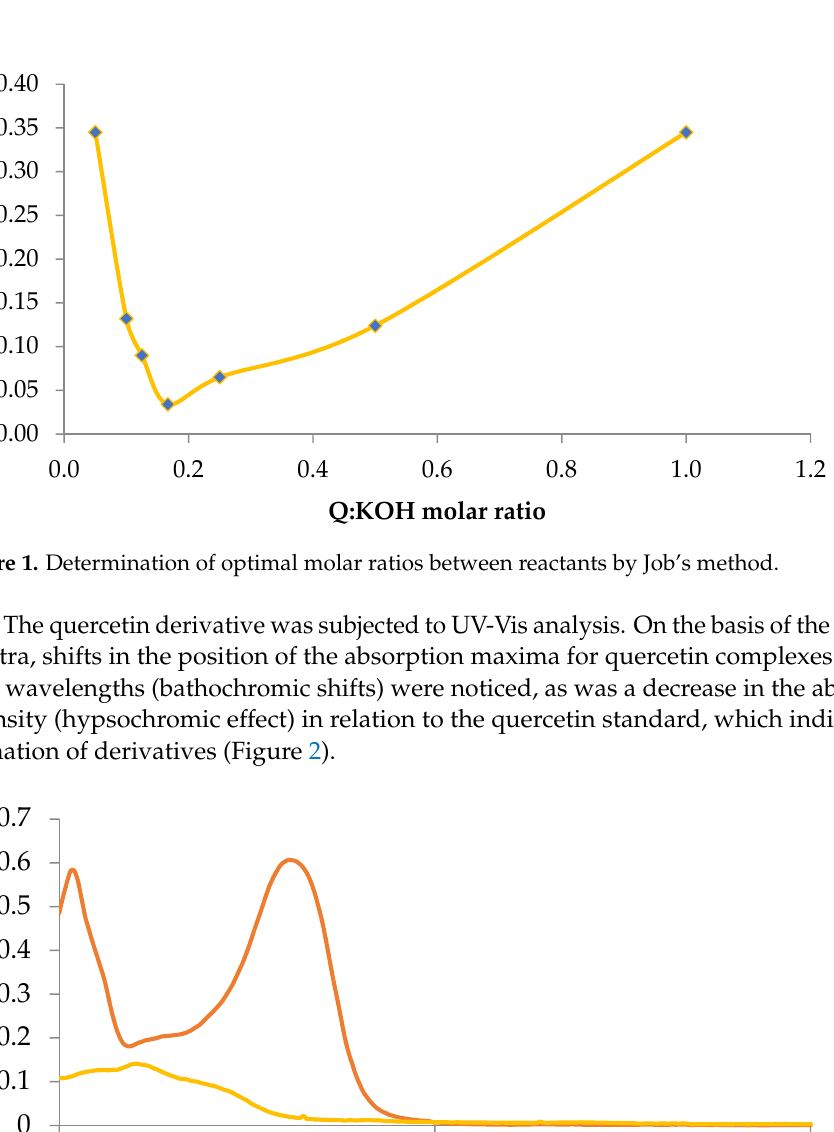
Figure 2. UV-Vis spectrum of potassium quercetin derivative and quercetin: Q—methanolic solution of quercetin with a concentration of 0.1 mg ∙ mL − 1 ; Q + K—methanolic solution of potassium quercetin derivative with a concentration of 0.1 mg ∙ mL − 1 .